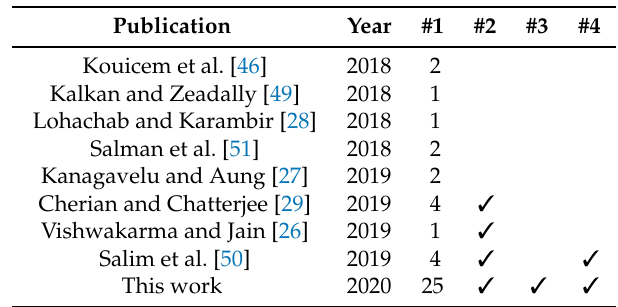
Table 2. Analysis of contributions provided by our proposal concerning featured parameters with respect to plain related